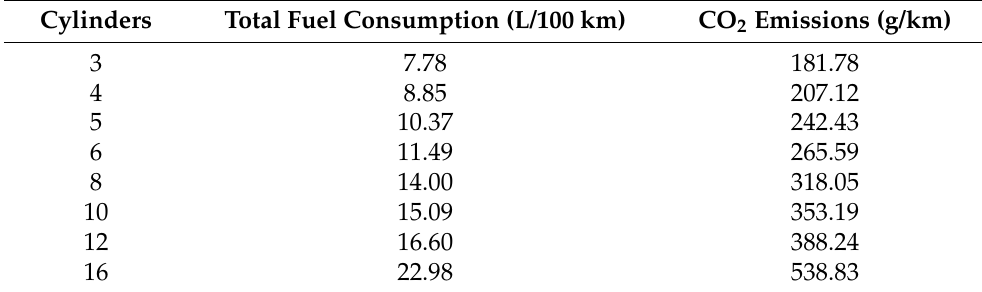
Table 6. CO 2 emissions (g/km) and total fuel consumption (L/100 km) of each cylinder.